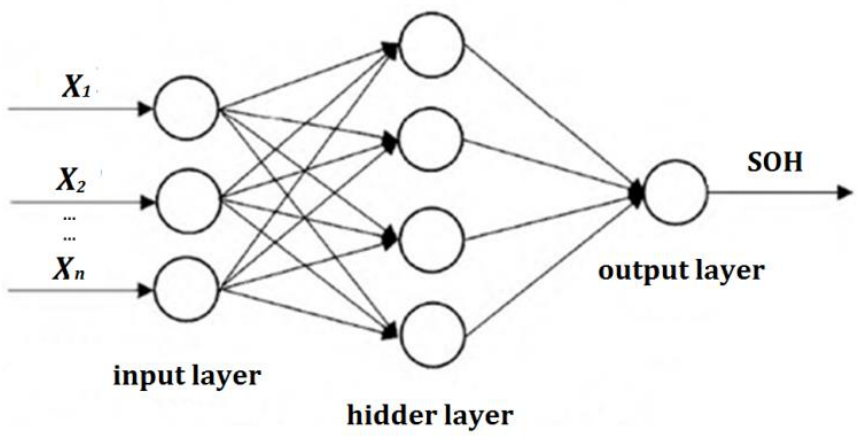
Figure 7. Structure of the BP neural network for model.